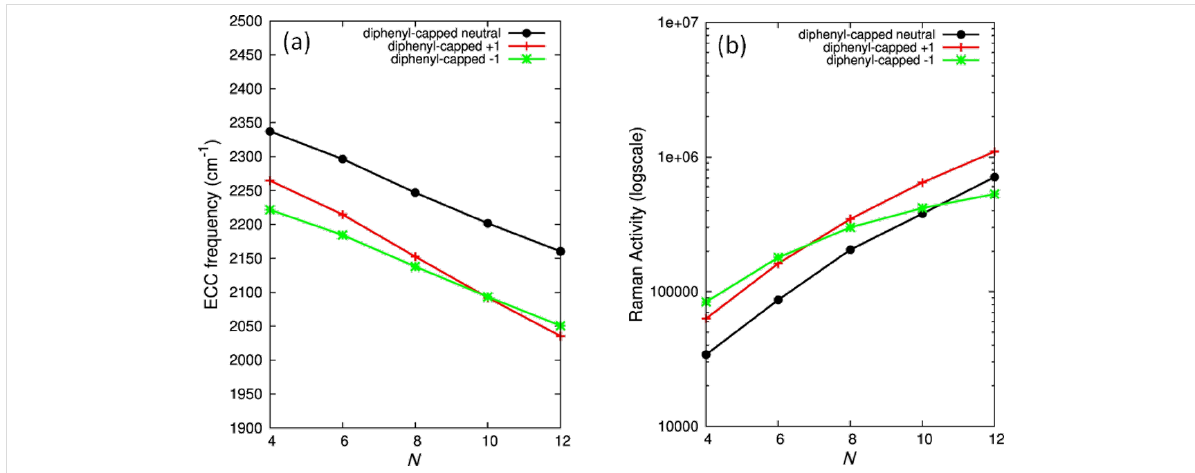
Figure 7: (a) Modulation of the DFT-computed [39] vibrational frequency and (b) Raman activity of the ECC band for phenyl-capped polyynes of different lengths ( N ) and charge states (0, +1, –1). Figure adapted with permission from [39], copyright 2011 American Chemical Society.